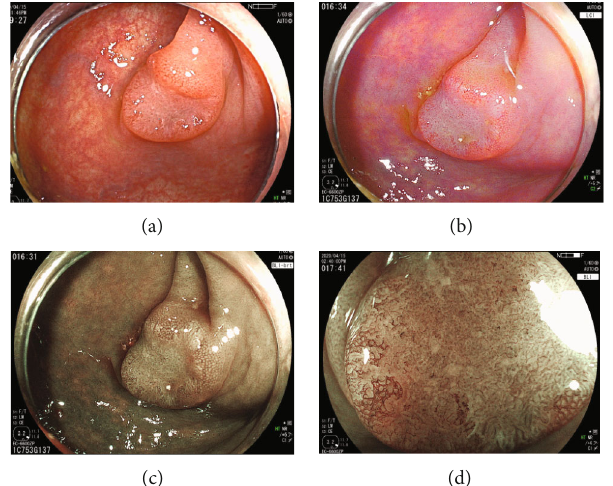
Figure 2: Case presentations of high-grade adenoma with an LED endoscope. (a) A nonpolypoid 10mm lesion at the descending colon. Histopathology: high-grade adenoma. (b). Linked color imaging. (c). Blue light imaging without magni fi cation. (d) BLI-LED, JNET Type 2B.